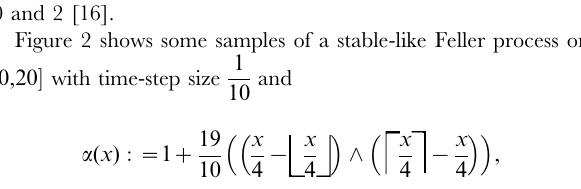
ffiffiffiffiffiffiffiffiffiffiffiffiffiffi { a 2 { b 2